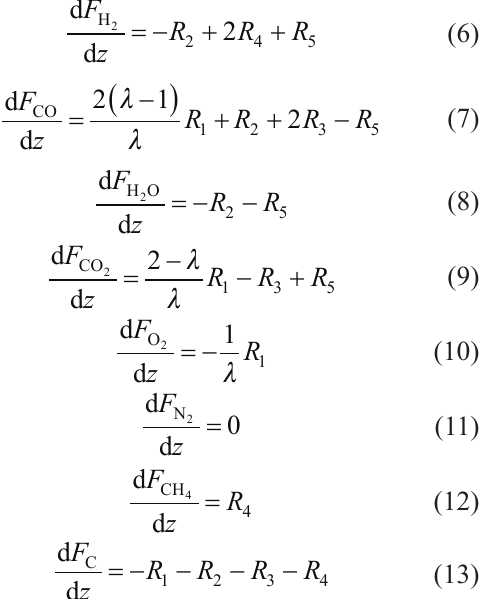
Table 1 – Kinetics of reactions occurring inside the reactor Reaction Kinetic